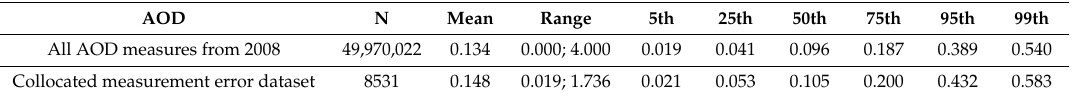
Table 1. Multi-Angle Implementation of Atmospheric Correction (MAIAC) aerosol optical depth (AOD) from Aqua in the measurement error dataset (collocated with AERONET) and across the region (for 2008).